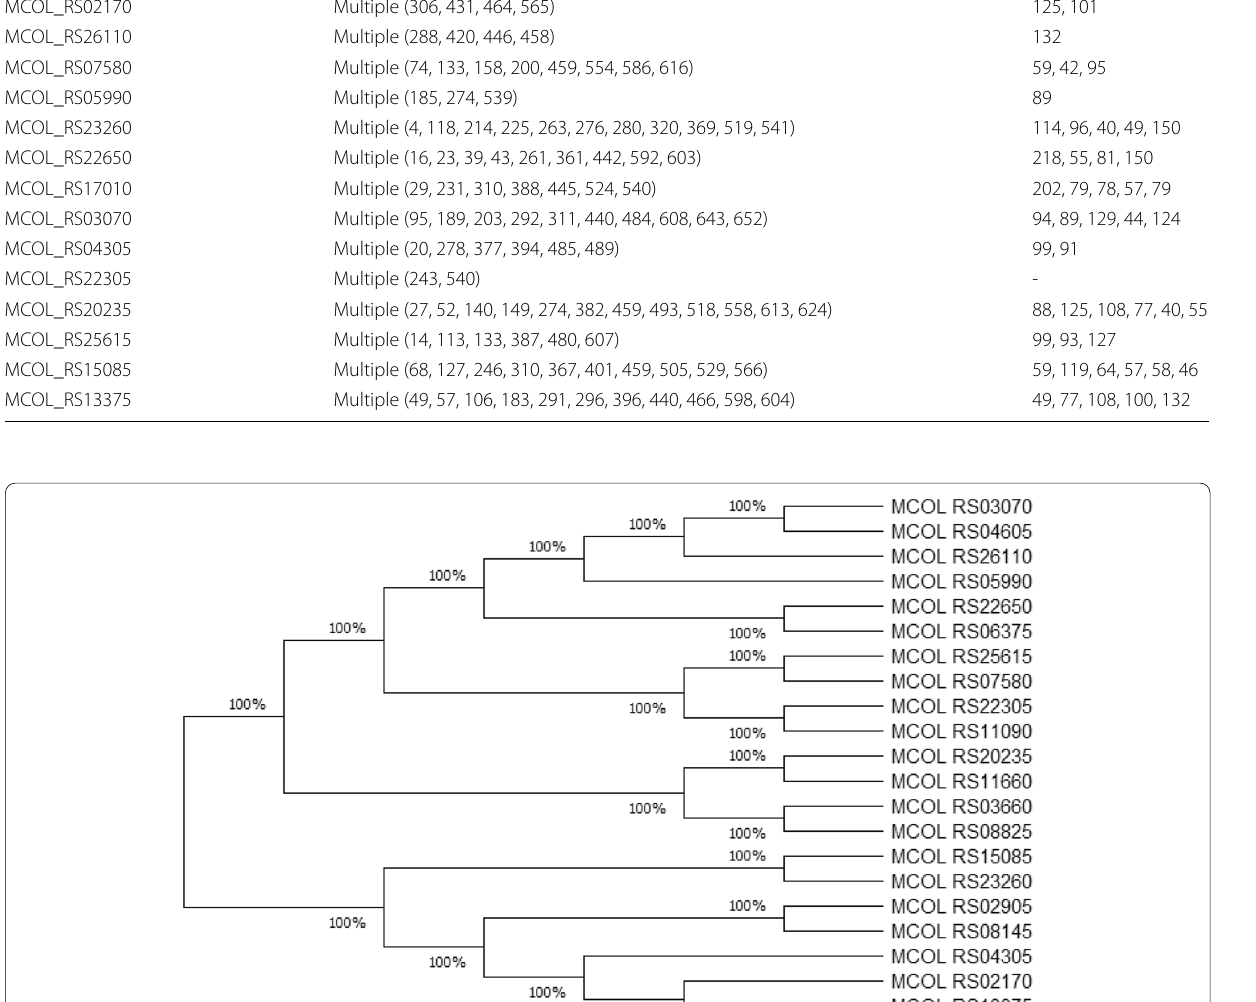
(Table 3). MTF1 matched with 4 AraC families, involved in pathogenesis by the production of virulence factors, dormancy survival and drug resistance by the formation of biofilms, cell-to-cell communication, and arginine